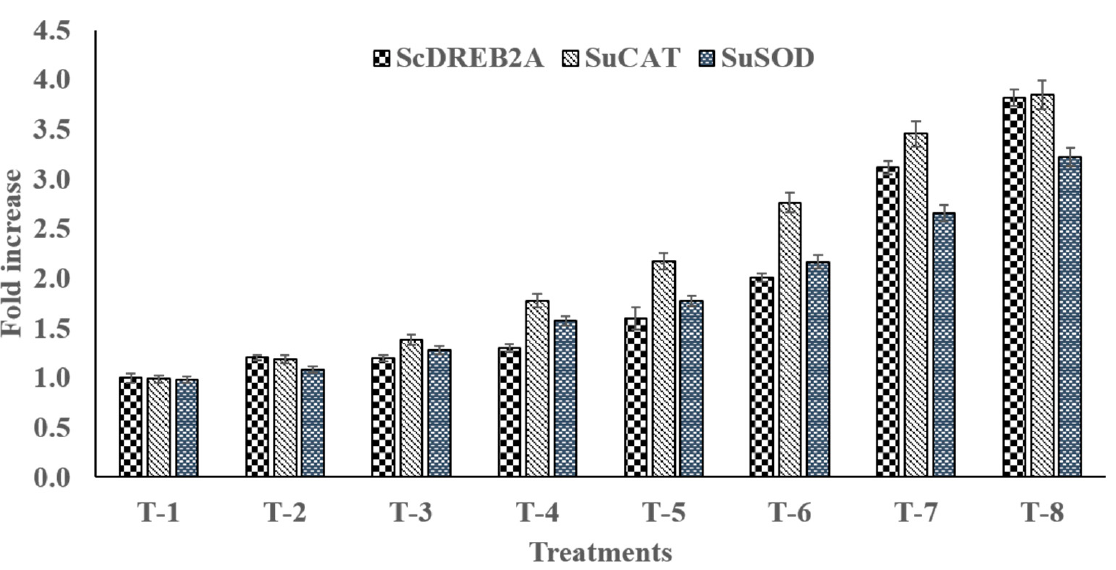
Figure 8. Effect of salt-tolerant PGPR ASN-1 and SNP application on expression of ScDREB2A , SuCAT and SuSOD gene. T-1: Un-inoculated control; T-2: SNP; T-3: PGPR ASN-1; T-4: PGPR ASN-1 + SNP; T-5: NaCl (200 mM); T-6: NaCl + SNP; T-7: NaCl + PGPR ASN-1; T-8: NaCl + PGPR ASN-1 + SNP. The mean ± SE, n = 3 is represented. Letters on each bar represent significant variances ( p ≤ 0.05) after the DMRT test.